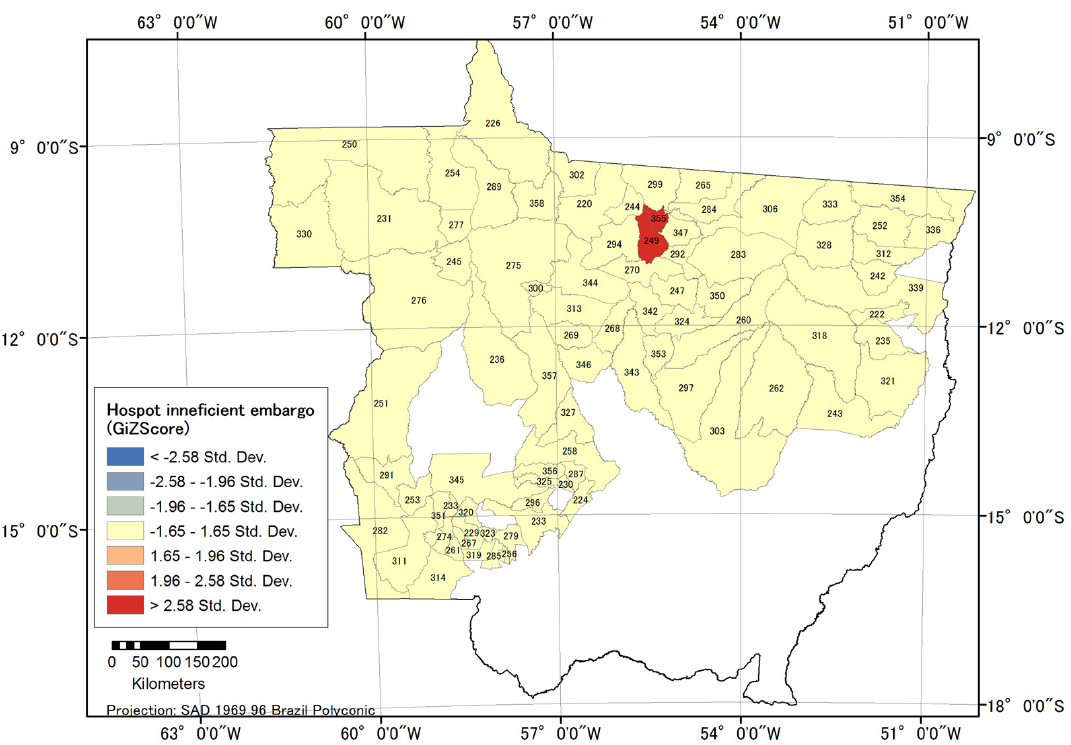
Figure 8. Hot spot map of ineffective embargoes.